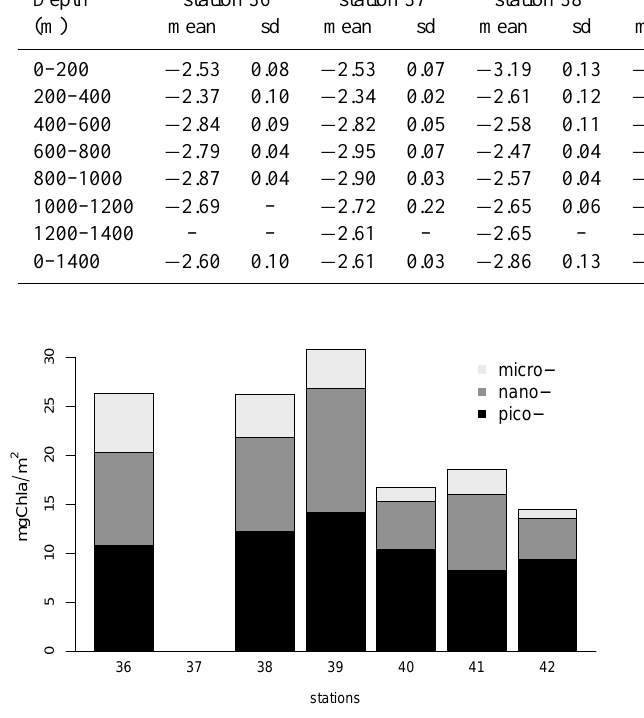
Figure 6. Total biomass of phytoplankton (in Chl a mgm − 2 ) with proportion of phytoplankton size class (note that no sampling was performed at station 37). Average of 6 to 10 samples per